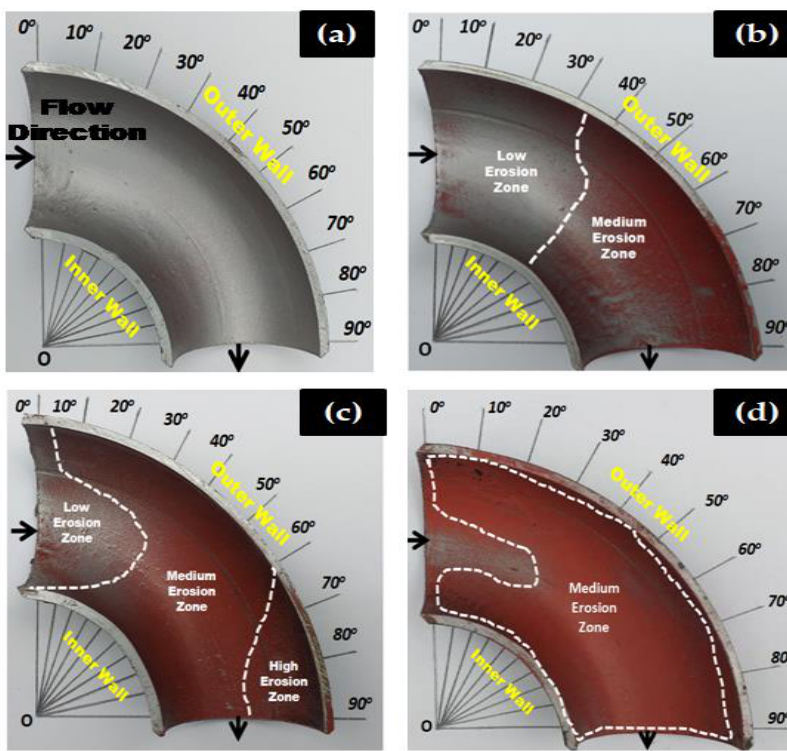
Figure 6. Paint erosion pattern for slug flow with V s L = 0.5 m/s and V s G = 2.5 m/s in a 90° horizontal-horizontal elbow bottom section. ( a ) Without sand [8], ( b ) 2 wt.% sand fines [8], ( c ) 5 wt.% sand fines [36], and ( d ) 10 wt.% sand fines.